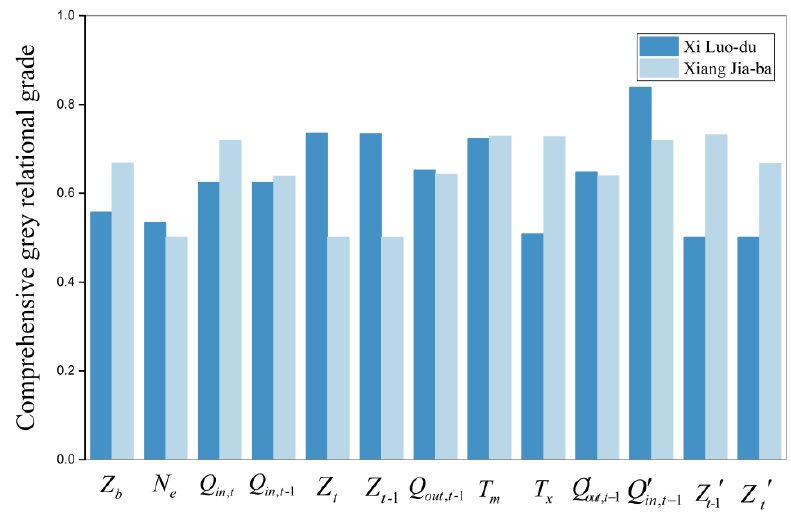
Figure 3. Grey relational grade between different correlation factors and decision variable. Table 2. The relational grade determined by GRA.